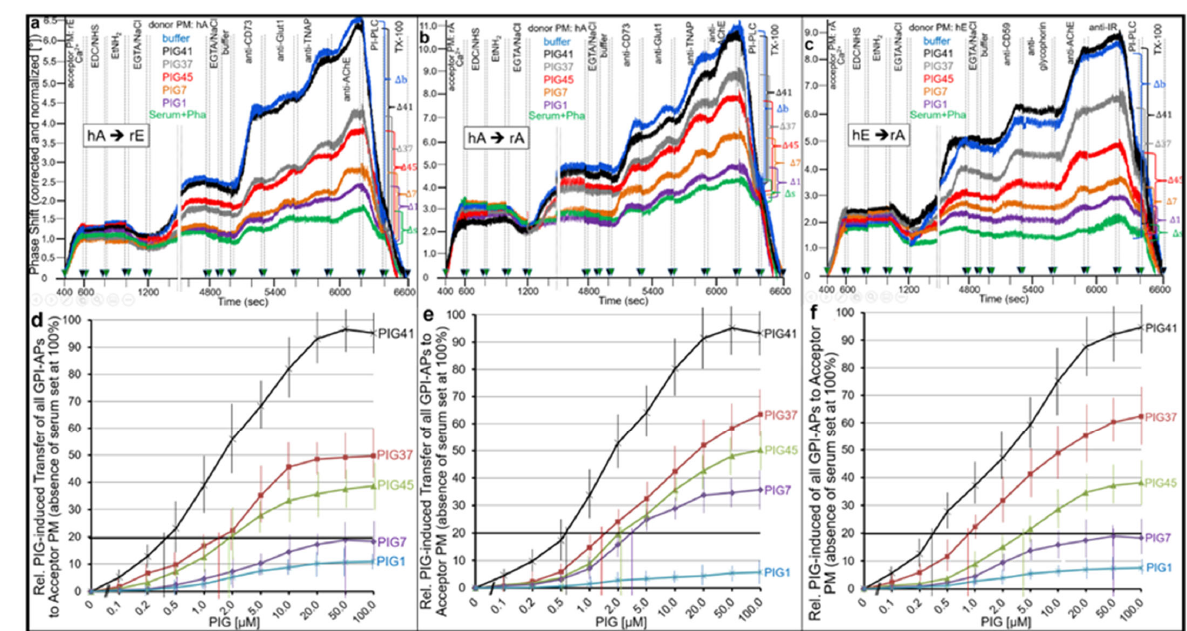
Figure 5. Effect of serum and PIGs on the cell ‐ free transfer of full ‐ length GPI ‐ APs from donor to acceptor PM. Human adipocytes of lipid-loading stage IV (see Supplementary Materials, Figure